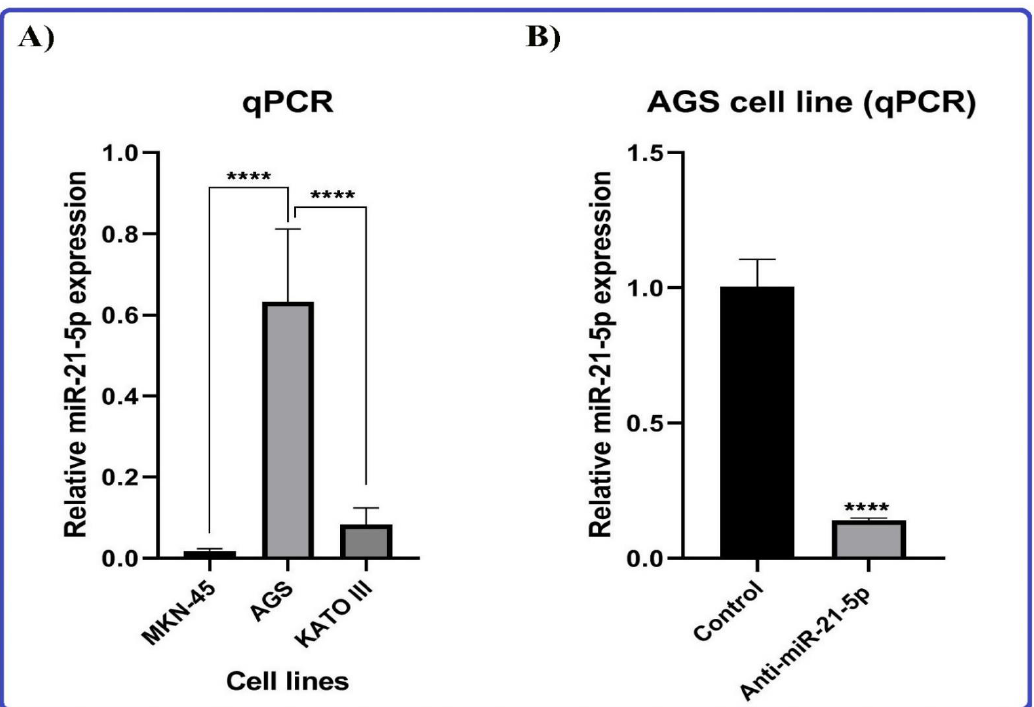
Figure 9. ( A ) Relative miRNA-21 expression in MKN-45, AGS, and KATO III cell lines by qRT-PCR. ( B ) Relative miRNA-21 expression in AGS cell line treated with Anti-miR-21 and control cell line by qRT-PCR. **** indicates P value < 0.0001.